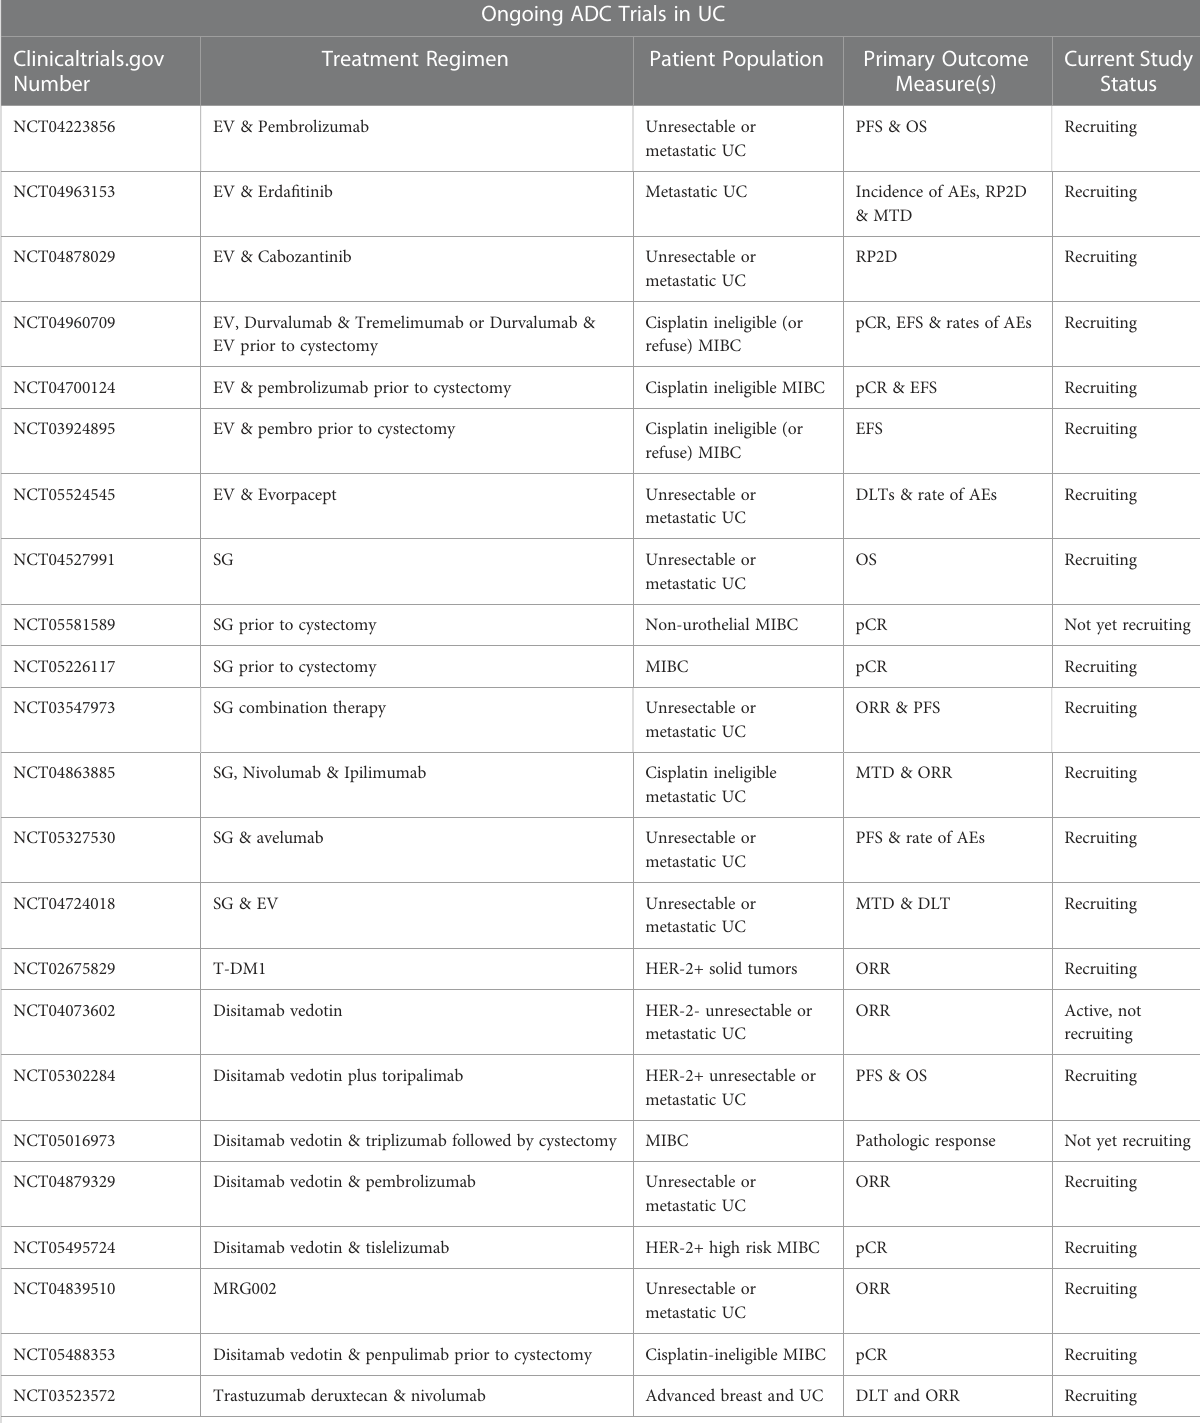
TABLE 2 Currently active trials of antibody-drug conjugates in urothelial